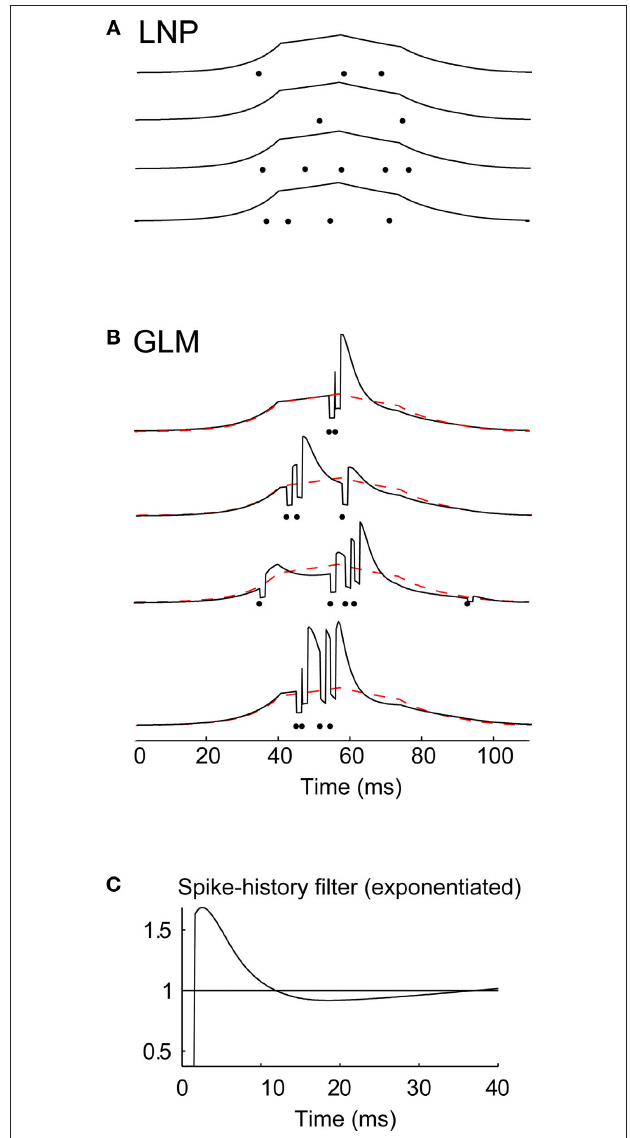
Figure 6 | The influence of spike history on spike timing within firing events. (A) Conditional intensity functions associated with a local event for four different trials generated by the LNP model fitted to an X-ON cell, for a given 100-ms period in the movie stimulus. For each trial the conditional intensity function (black curve) is plotted along with the resulting spikes (black dots). (B) Conditional intensity functions generated by the GLM fitted on the same cell, along with the corresponding spikes generated by the model, for four repetitions of the same 100-ms period in the movie. The conditional intensity function from the LNP model in (A) is superimposed for comparison (dashed red curve). Same conventions as in (A) . (C) Spike-history filter for this cell (after exponentiation), as fitted with the GLM. The filter is shown for the first 40 ms to highlight the effects of spike history on a short-time scale.